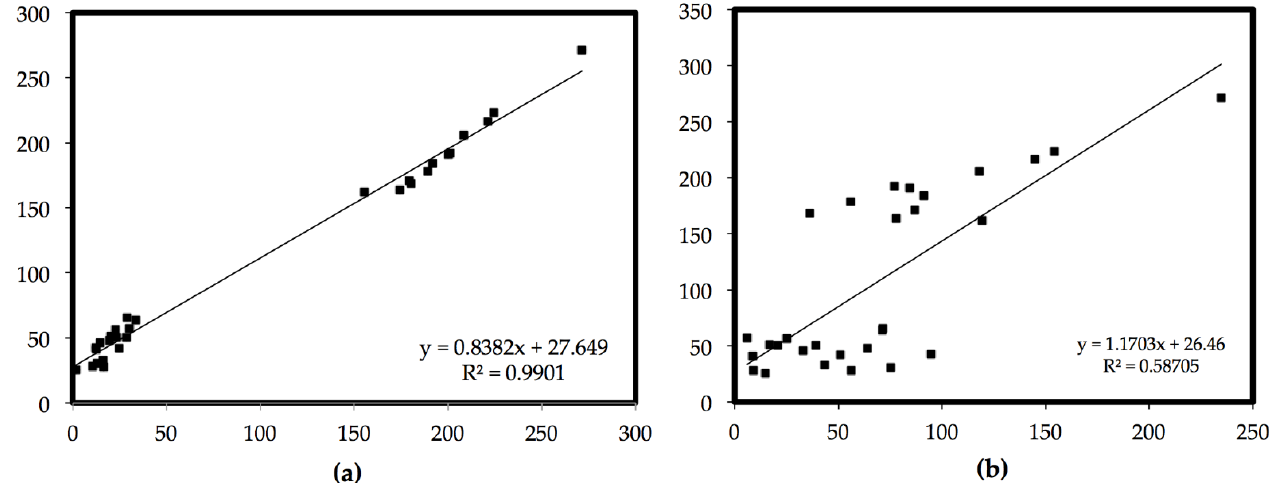
Figure 4. Test dataset comparison. Least-square line equation and the square of the linear correlation coefficient are also shown for ( a ) Hoke D6 design and ( b ) composite factorial design. Both axes represent b in Ws 1/2 m −2 K.